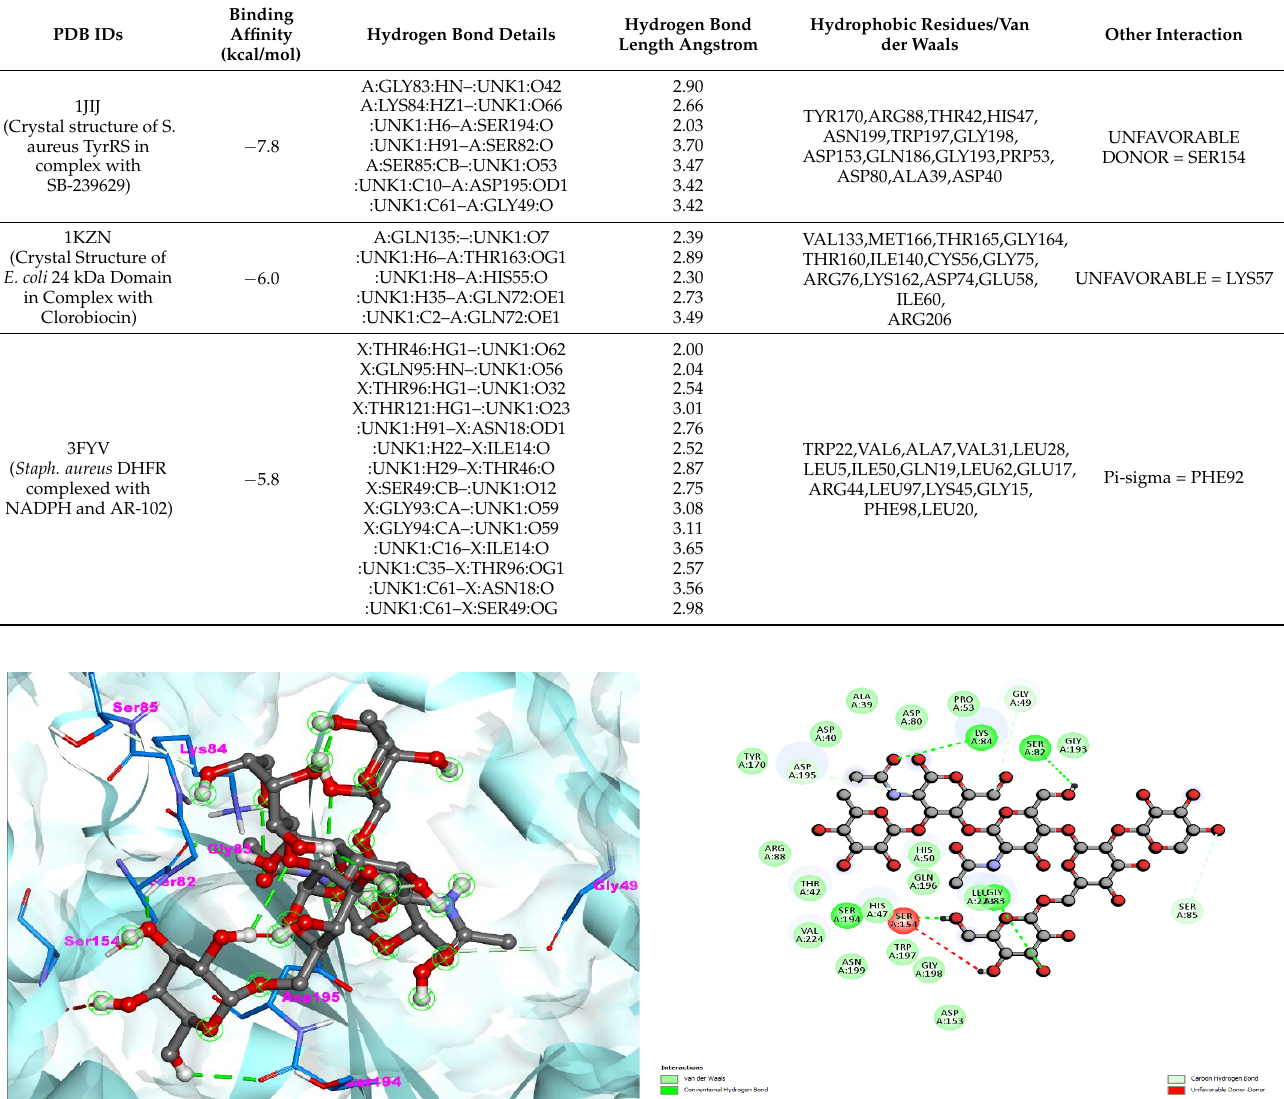
Table 2. Bromelain docking studies against bacteria receptors. Where in Hydrogen bond details column UNK1 = Bromelain.